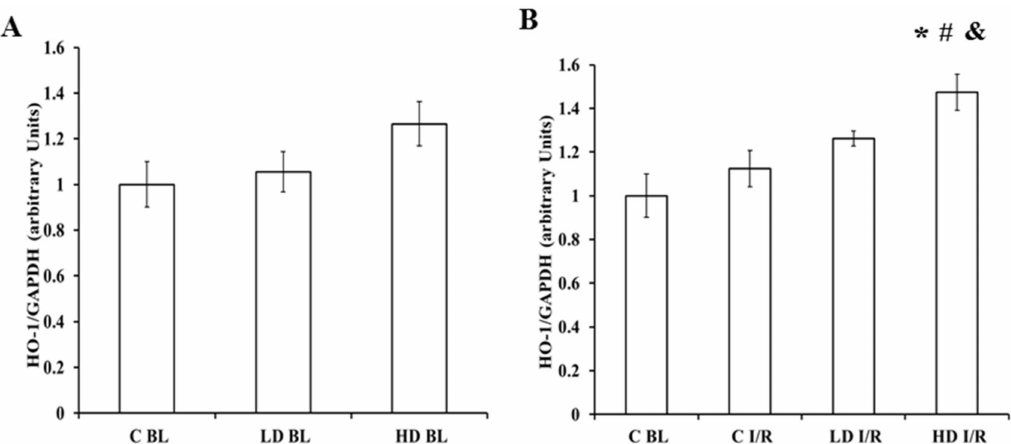
Figure 3. The Western blot analysis for cardiac expression of the HO-1 protein. Expression of the HO-1 protein in rat myocardiums was measured in the homogenized cardiac tissue samples from vehicle- or BC-treated hearts, with ( B ) or without ( A ) ischemic/reperfused (ISA/REP) injury. The signal intensity of the resulting bands corresponding to the HO-1 protein was measured using the Scion for the Windows Densitometry Image program. The tissue content of each protein is shown as a ratio of arbitrary units for the HO-1 protein to GAPDH signal. Data are expressed as the mean ± SEM of the 6 different blots. * p < 0.05 for the comparison of the average levels of HO-1 in the ventricular myocardium of BC-treated animals versus non-ischemic control (C-BL) hearts. # p < 0.05 for the comparison of the average levels of HO-1 in the ventricular myocardium from BC-treated animals subjected to ISA/REP versus ISA/REP-injured control (C-I/R) hearts. & p < 0.05 for the comparison of the average levels of HO-1 in the ventricular myocardium from high dose beta-carotene treated (HD-BC) animals subjected to ISA/REP (HD-I/R) versus LD-BC treated and ISA/REP-injured (LD-I/R) hearts.